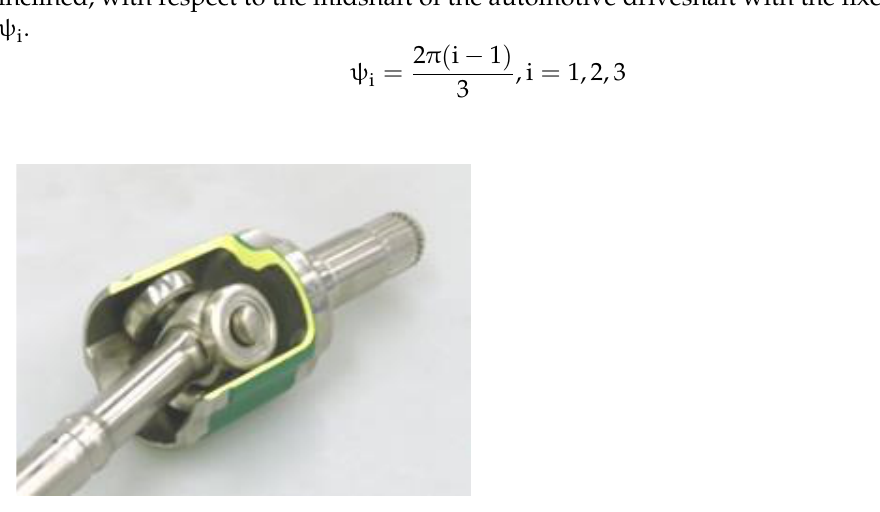
Figure 4. Tulip – tripode joint. Figure 4. Tulip–tripode joint.